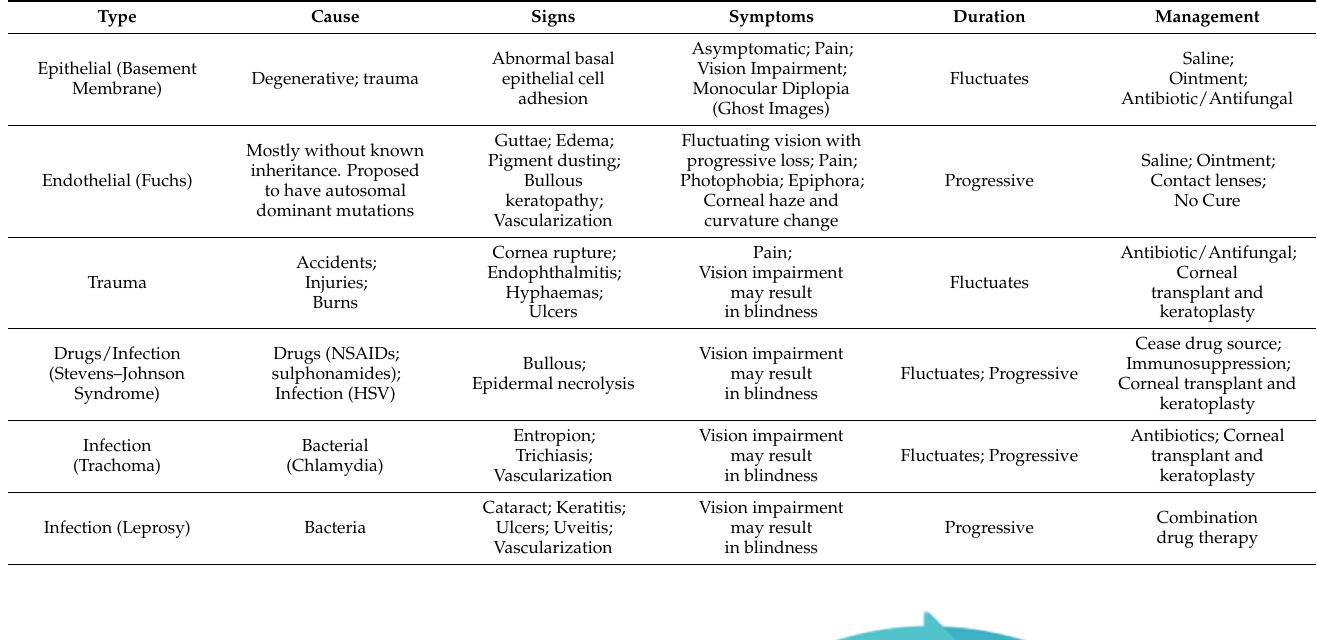
Table 1. Common types and cause of corneal scarring/fibrosis diseases with corresponding clinical signs, symptoms, duration, and management options.